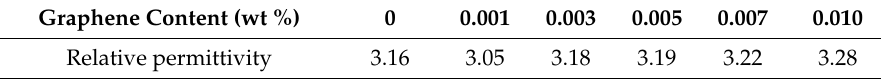
Figure 4. Surface potential decay in graphene/silicone rubber nanocomposites.